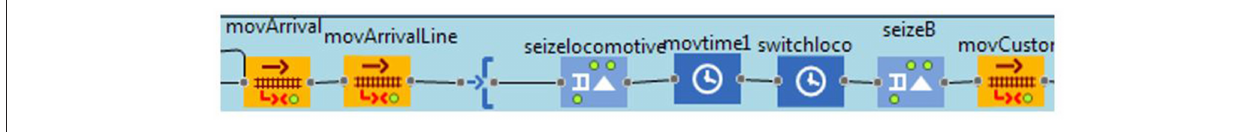
FIGURE 3 | Section of the block sequence.